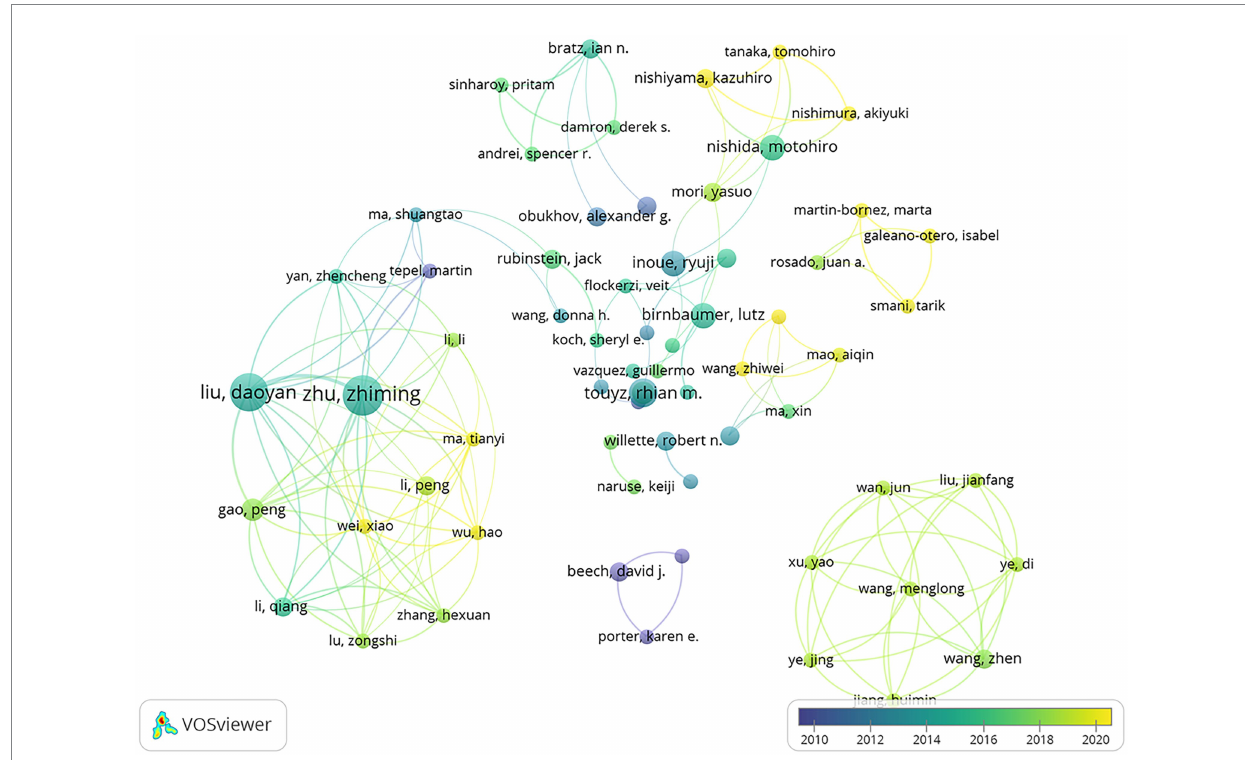
FIGURE 7 Overlay visualization of co-authorship analyzed in the method of Association strength, weighted by citations, scored by average year of publication. The strength of the relationships is indicated by the thickness of the lines. The average year of publication is represented by the color of the circle.